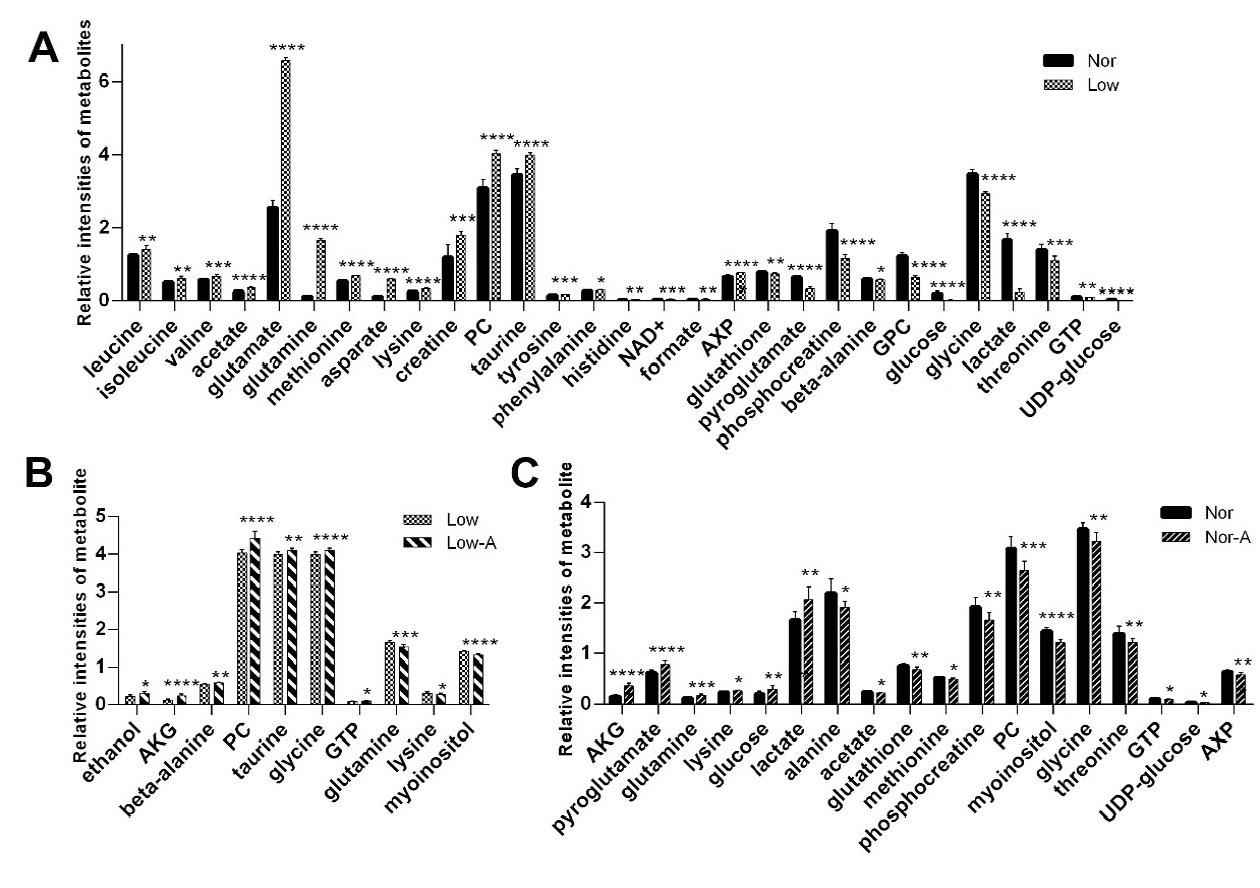
Figure 4. Relative intensities of differential metabolites identified from pairwise comparisons between the four groups of C2C12 myoblasts. ( A ) Low vs. Nor; ( B ) Low-A vs. Low; ( C ) Nor-A vs. Nor. * p < 0.05, ** p < 0.01, *** p < 0.001, **** p < 0.0001. n = 9 for each group.